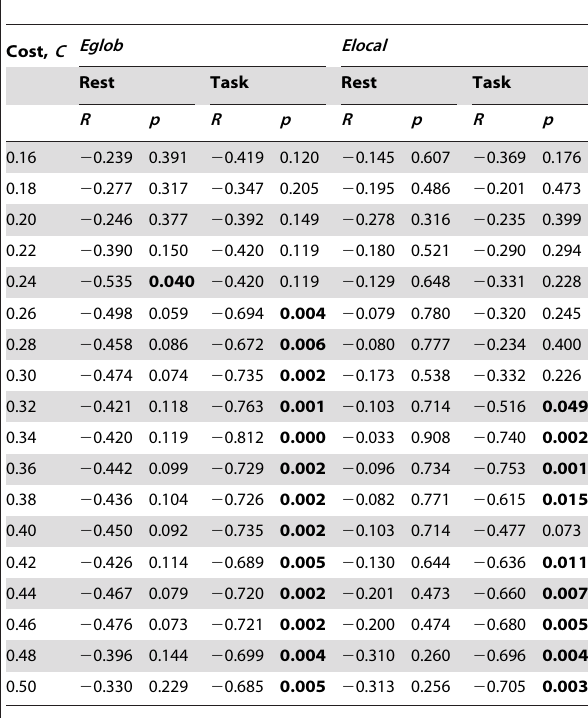
Table 5. Correlation coefficients R and p values between Eglob , Elocal and duration of disease at each cost in the range of 0.16 , C , 0.50 in the beta band network.